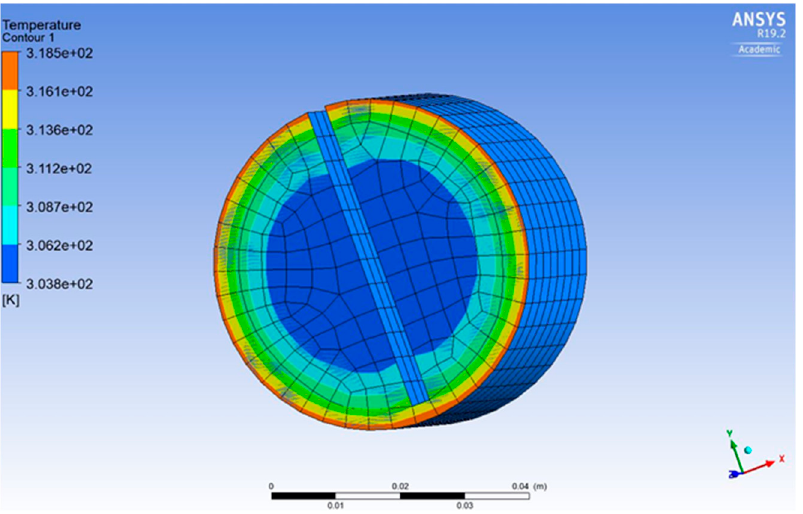
Figure 7. Temperature nephogram through the cross-section of the sample during the heat treat- ment process.